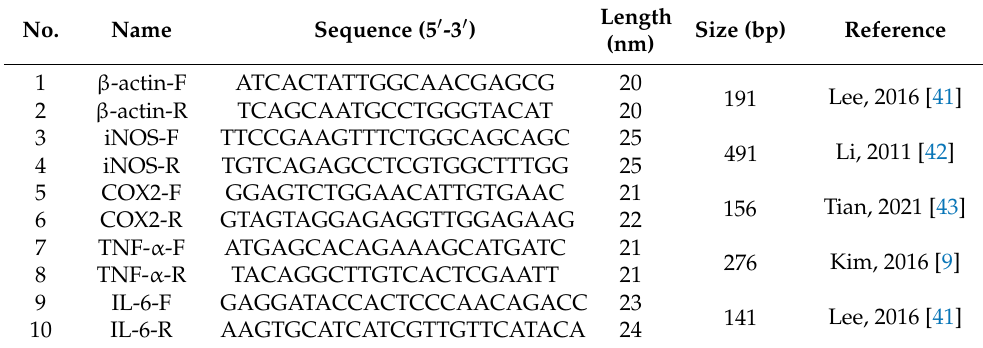
Table 3. Primers for